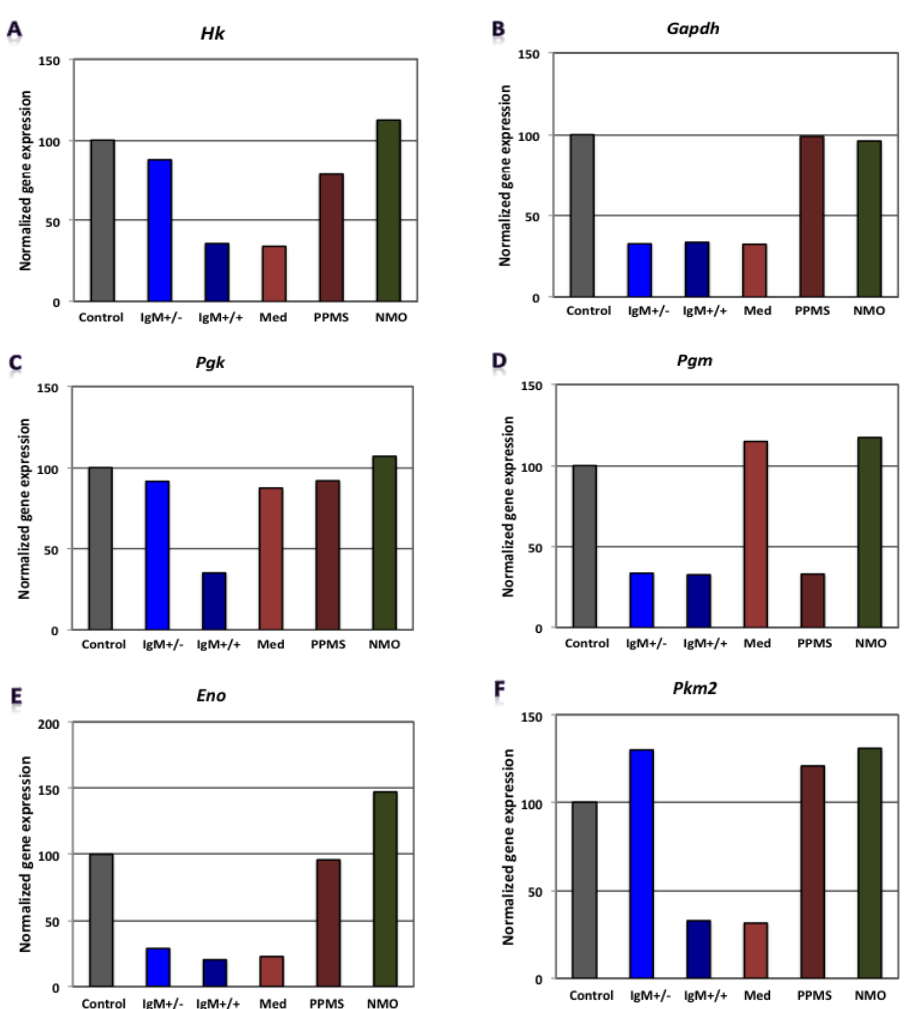
Figure 2. Normalized gene expression involved in glycolytic pathway in CGNs treated with CSF of MS and Neuromyelitis optica (NMO) patients. ( A ) Hexokinase Hk; ( B ) Glyceraldehyde-3-phosphate dehydrogenase, Gadph; ( C ) Phosphoglycerate kinase, Pgk; ( D ) Phosphoglycerate mutase, Pgm; ( E ) Enolase, Eno; ( F ) Pyruvate kinase isozyme M2, Pkm2. CGNs: cerebellar granule neurons; RMS (G+/M− and G+/M+): types of inflammatory MS; SMS: Spinal—MS (Med); PP: Primary progressive multiple sclerosis; NMO: Neuromyelitis Optica.